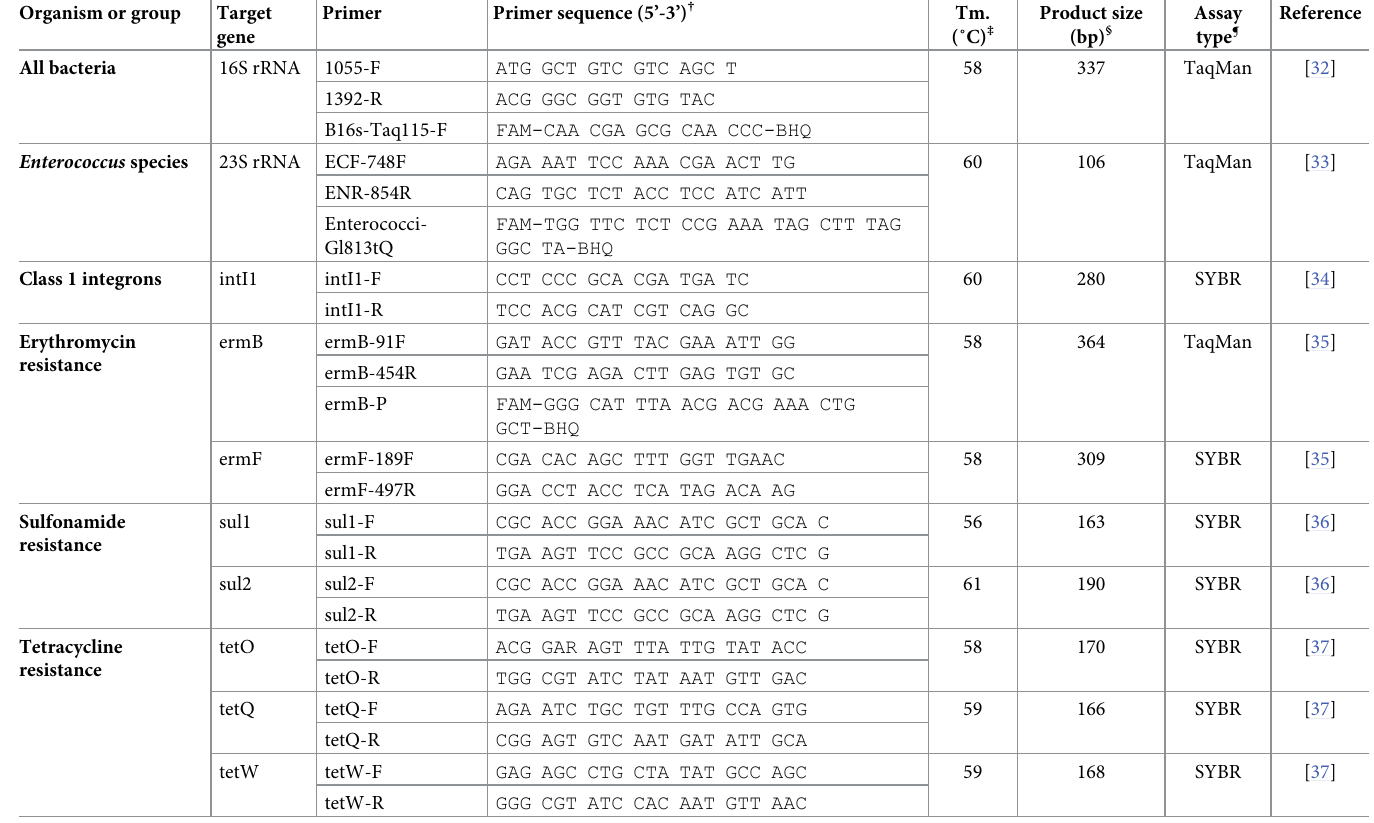
Table 1. Sequences, target size and melting temperature of primers